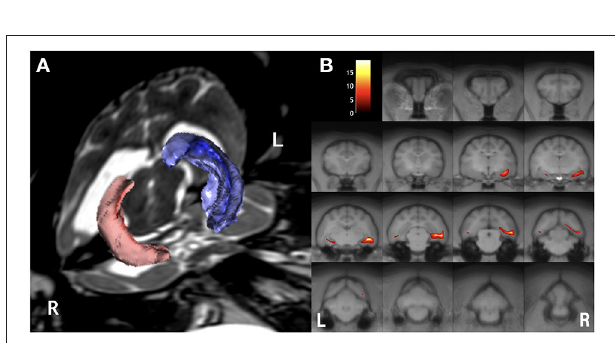
FIGURE 2 | Preoperative structural MRI. Transverse T2-weighted (A) , T1-weighted (B) , and contrast-enhanced T1-weighted (C) images at the level of the medial geniculate body. The right temporo-occipital cortex and hippocampus were markedly atrophied with an extended ipsilateral lateral ventricle. The contralateral (left) ventricle was also slightly dilated.